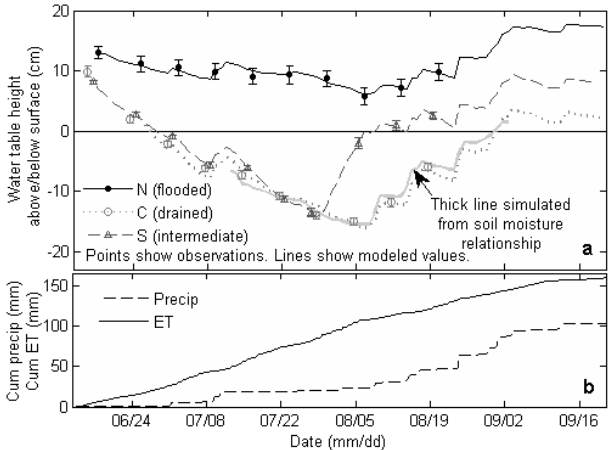
Figure 2. Water table position (a) measured during the growing season (points) and simulated 2 Fig. 2. Water table position (a) measured during the growing sea- son (points) and simulated in the autumn using an empirical model in the autumn using an empirical model (lines) until the refreezing of the active layer. The 3 (lines) until the refreezing of the active layer. The additional thick- additional thickened line for the Central (drained) section shows an independently simulated 4 ened line for the Central (drained) section shows an independently water table using the relationship between measured water table and soil moisture in the top 5 simulated water table using the relationship between measured wa- 10 cm of soil during the growing season. Error bars show standard error of the mean. The 6 ter table and soil moisture in the top 10 cm of soil during the grow- lower panel (b) shows cumulative adjusted precipitation and cumulative potential 7 ing season. Error bars show standard error of the mean. The lower panel (b) shows cumulative adjusted precipitation and cumulative evapotranspiration from 15 June 2009 (used in the water balance model). 8 potential evapotranspiration from 15 June 2009 (used in the water balance